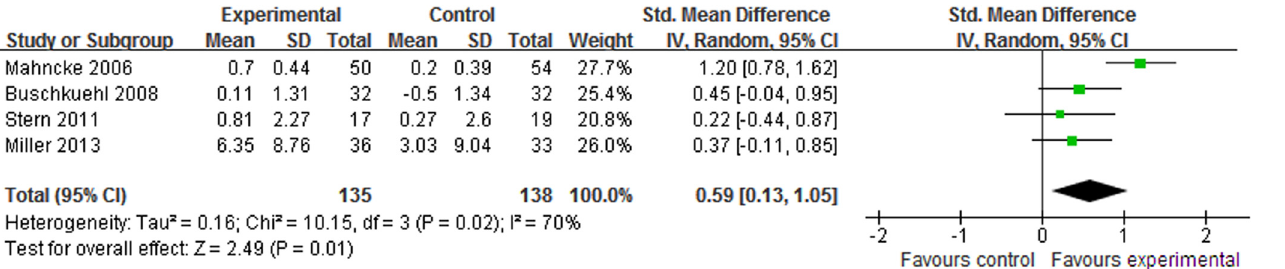
Fig 6. Forest plot of the long-term effect of computer-based cognitive programs in memory